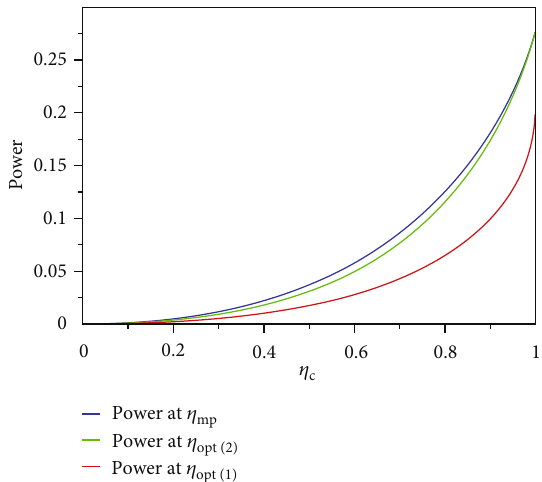
Figure 3: Power output versus η c at maximum power and two cases of optimization criteria condition.